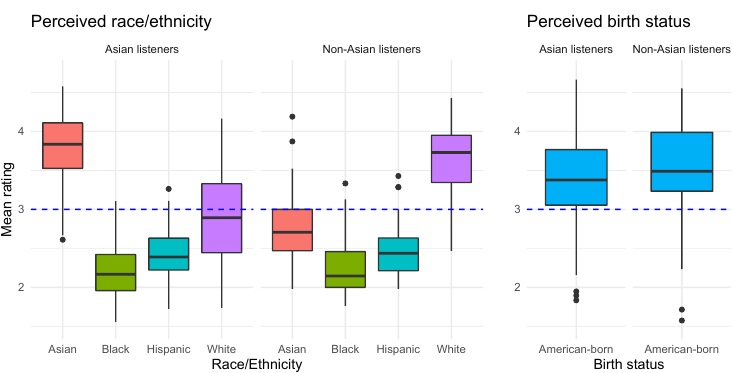
Figure 4. Asian listeners (n = 37) were more likely to rate the Korean American voices as being Asian but not White, whereas non-Asian listeners (n = 68) showed the opposite tendency, identifying most of the Korean American voices as likely to be White, but not Asian. Both listener groups identified the speakers as being, on average, more likely to be American-born than foreign-born.